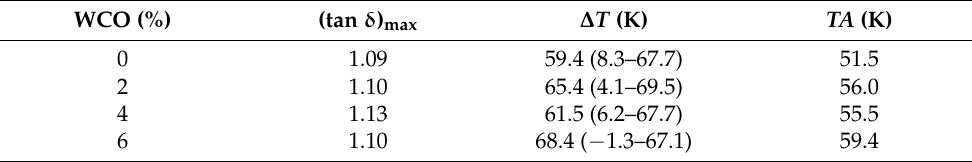
Table 3. Damping parameters of the unmodified and WCO-modified EAR binders.